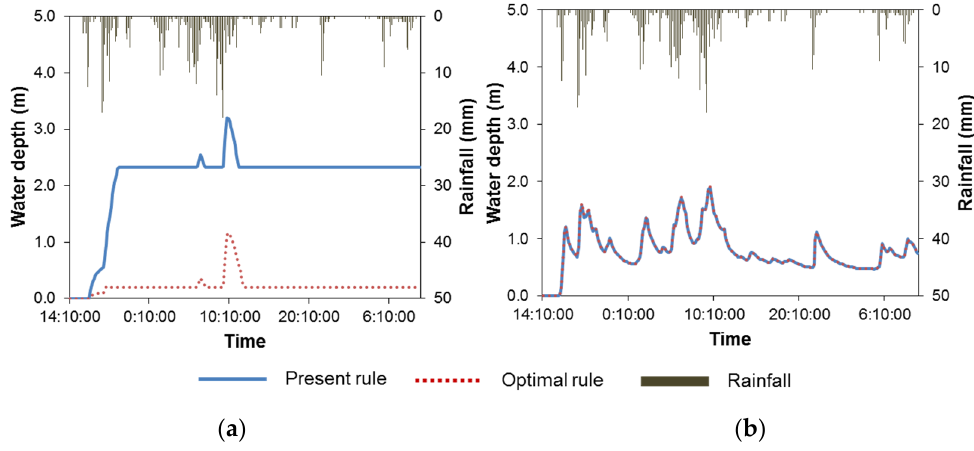
Figure 8 . Comparison of current and optimal detention reservoir facilities in terms of water depth at